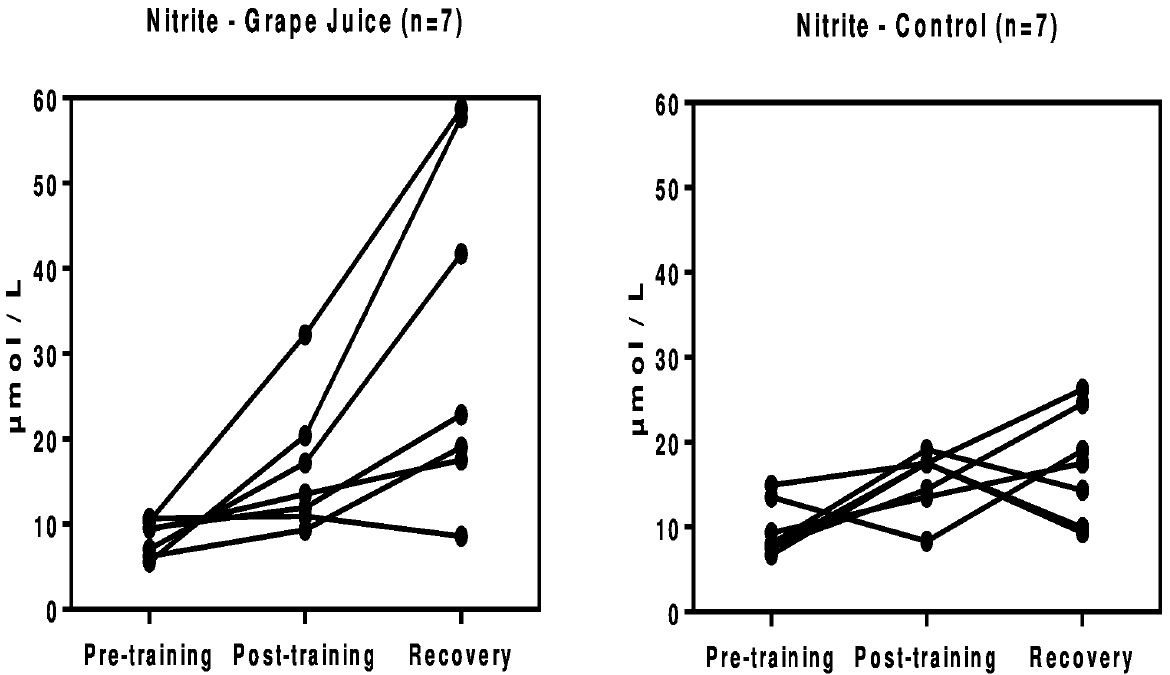
Figure 2. The individual response of each subject (plasmatic